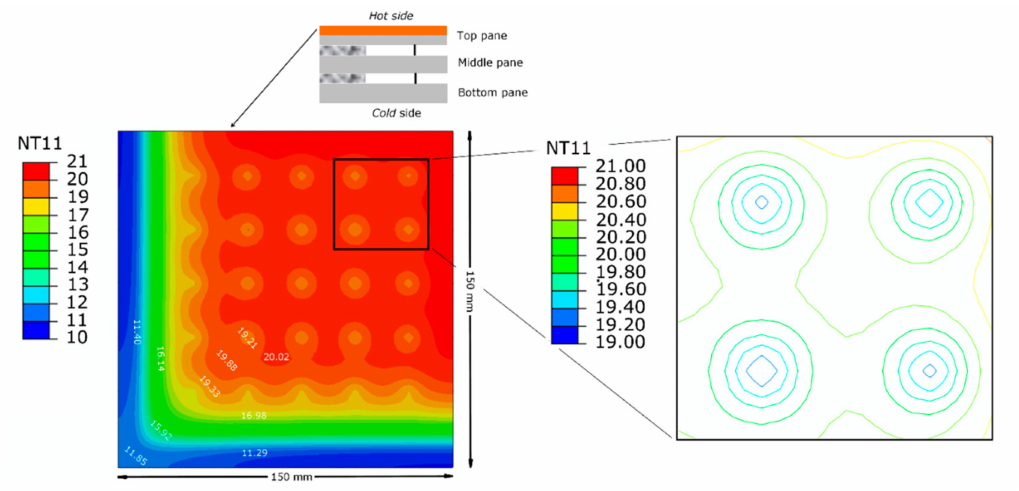
Figure 3. The isothermal temperature distribution (NT11 band) on the warm-side glass pane surface of the TVG, showing the temperature disparities (in ◦ C) from the 10-mm wide edge-sealed area towards the centre-of-pane area due to the use of a 10-mm wide edge-seal.